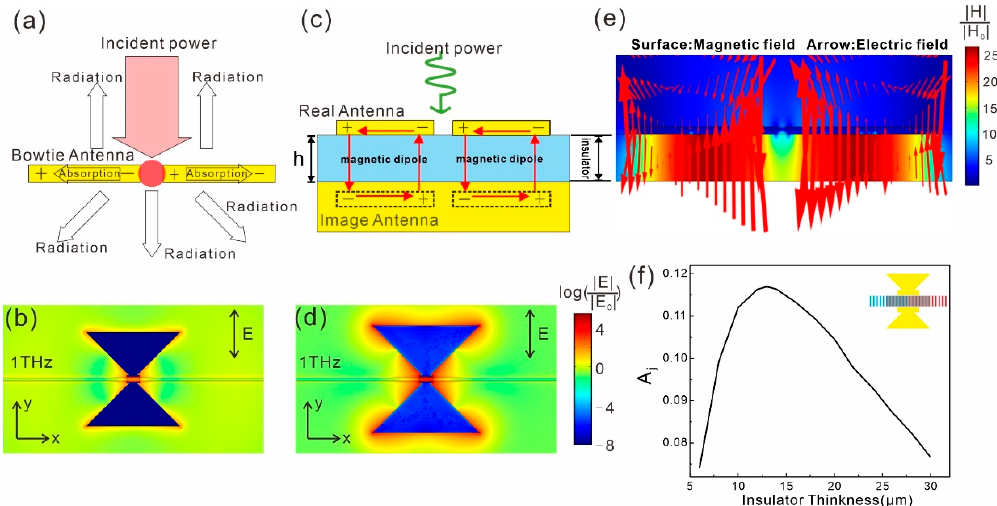
Figure 3. ( a ) Schematic diagram of modeling a bowtie antenna as a resonator using coupled mode theory. ( b ) Electric field enhancement distributions (log(| E |/| E 0 |)) on the x - y cross section at the center of the SWCNT film ( z = 1 μ m) integrated with the bowtie antenna at 1 THz for y -polarization. ( c ) Schematic diagram of the engineered antenna integrated SWCNT film. Each wing couples with its image and induces a magnetic dipole. ( d ) Same as ( b ) for the SWCNT film integrated with an engineered antenna (with bottom metal plane). ( e ) Electromagnetic field distribution of the engineered antenna integrated SWCNT film on a y-z cross section at x = 0. ( f ) A j as a function of the thickness of the insulator spacer in the engineered antenna integrated SWCNT film for y -polarization at 1 THz. The junction area is defined as a 5 μ m × 100 μ m × 2 μ m box at the center of the SWCNT film, as shown by the gray shade in the inset. E 0 in ( b , d ) denotes the electric field of the incident Gaussian beam at the junction.